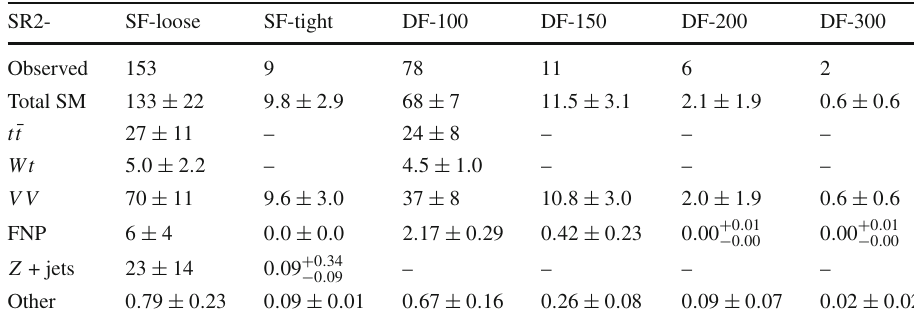
For both the 2 (cid:4) + 0 jets and 2 (cid:4) + jets channels, reducible Table 12 SM background results in the 2 (cid:4) + jets SRs. All system- atic and statistical uncertainties are included. The “top” background backgrounds with one or two FNP leptons arise from mul- includes all processes producing one or more top quarks and the “other” tijet, W + jets and single-top-quark production events. For backgrounds include all processes producing a Higgs boson or V V V . both analyses, the FNP lepton background is estimated from A “–” symbol indicates that the background contribution is negligible data using the matrix method (MM) [93]. This method uses SR2- Int High two types of lepton identification criteria: “signal”, corre- sponding to leptons passing the full analysis selection, and “baseline”, corresponding to candidate electrons and muons as defined in Sect. 5. Probabilities for real leptons satisfy- ing the baseline selection to also satisfy the signal selection are measured as a function of p T and η in dedicated regions enriched in Z boson processes; similar probabilities for FNP leptons are measured in events dominated by leptons from – heavy flavour decays and photon conversions. The method uses the number of observed events containing baseline– baseline, baseline–signal, signal–baseline and signal–signal